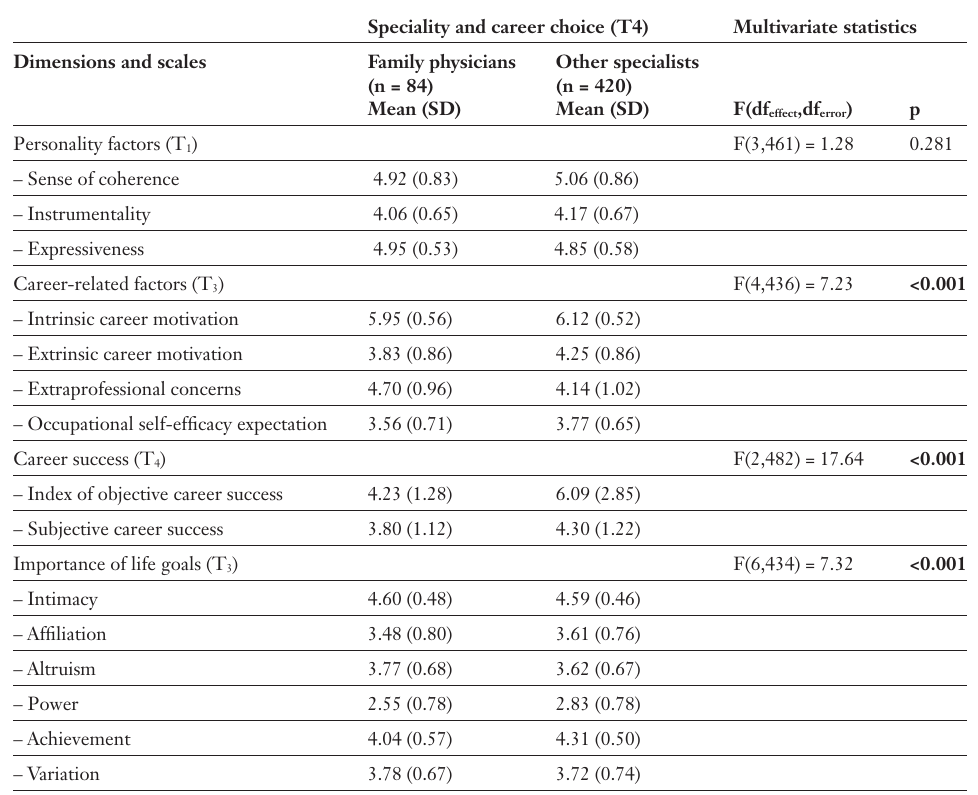
Table 3 Means (Sd) of per- sonality and career- related factors, career success and importance of life goals in future family physicians versus other specialists. Results of multivari- ate analyses of co- variance (covariate: gender) (N = 504).